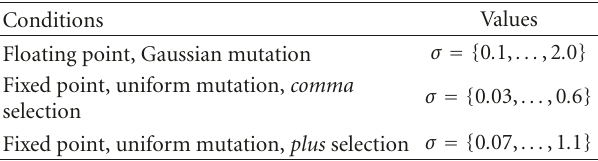
Table 12: Initial mutation strength